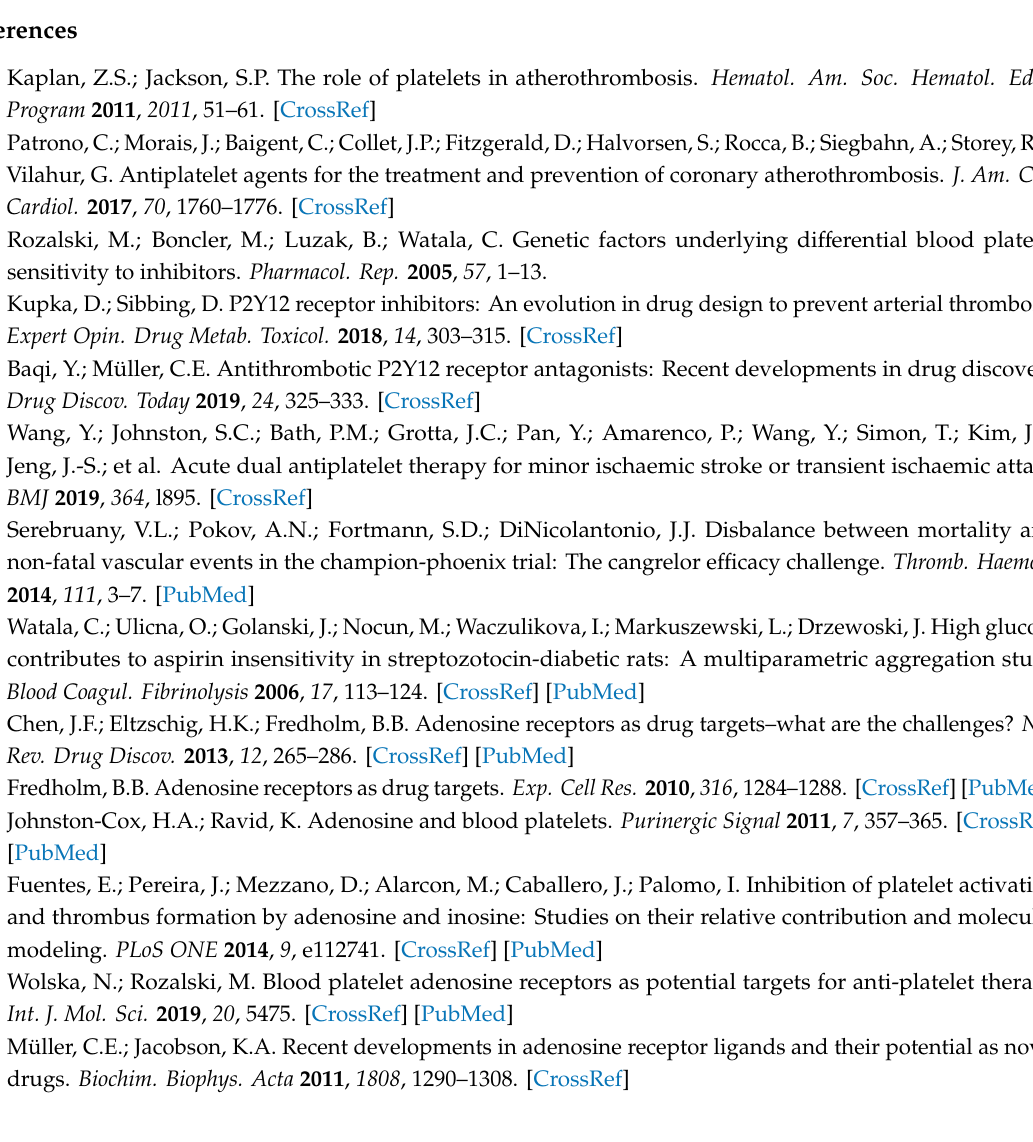
Figure S1. Representative cytometric dot-plots and histograms showing dual e ff ect of AR agonist (UK432,097) and P2Y 12 antagonists (cangrelor and prasugrel metabolite) in whole blood on the expression / binding of platelet surface activation markers and intracellular calcium mobilisation.; Table S1. E ff ects of AR agonists on platelet viability; Table S2. The e ff ects of adenosine receptor agonists and P2Y 12 antagonists on VASP